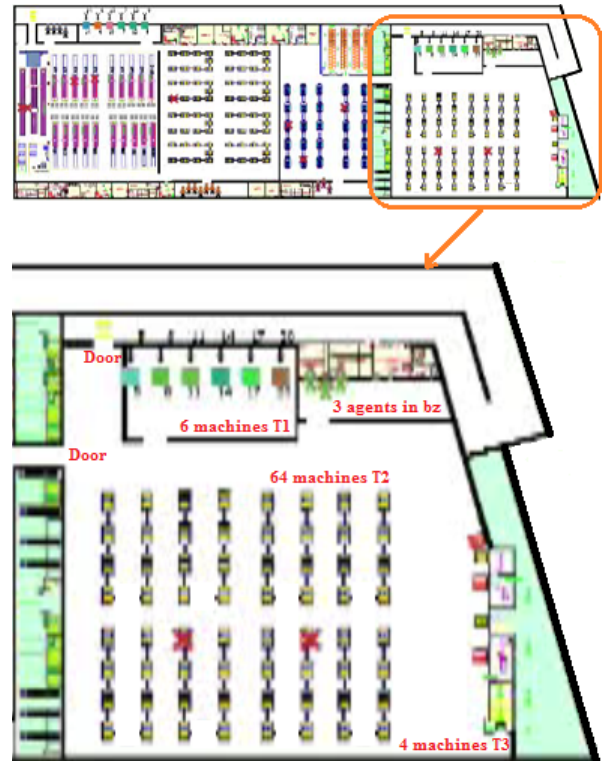
Figure 5. The considered factory production section